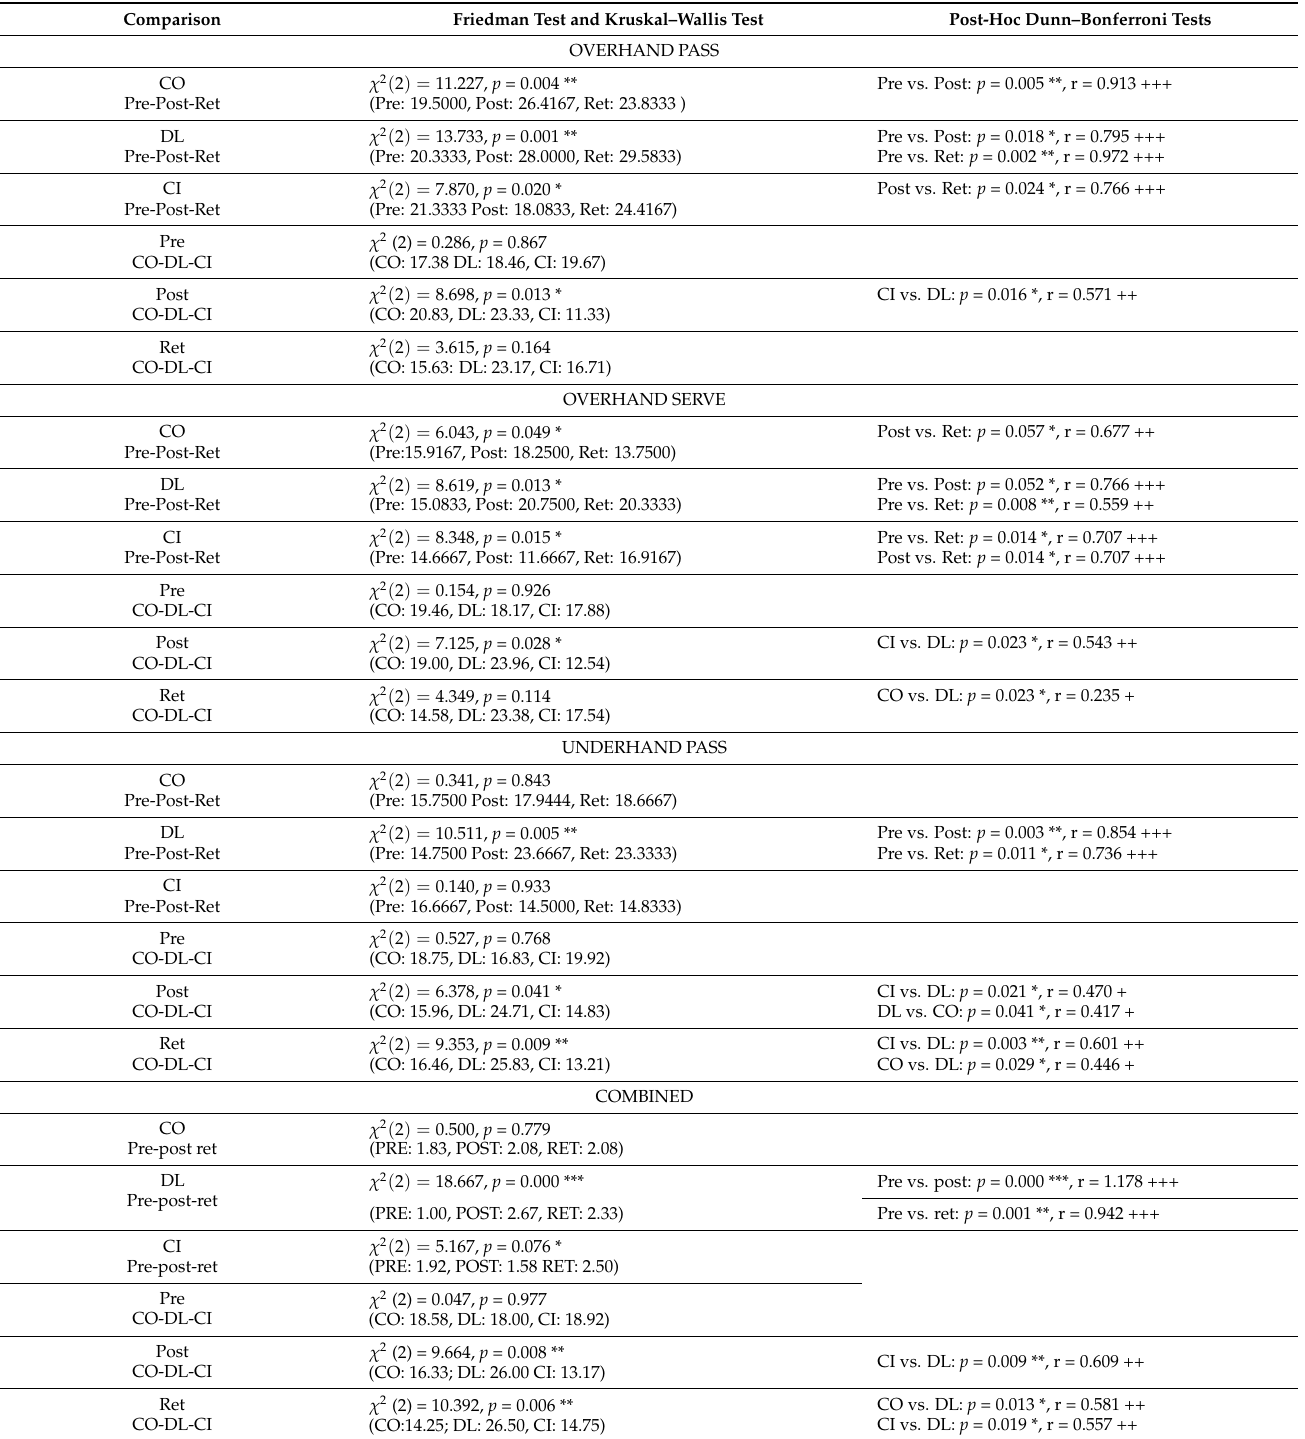
Table 3. Statistical comparisons at the three measurement time points within and between groups. Comparison Friedman Test and Kruskal–Wallis